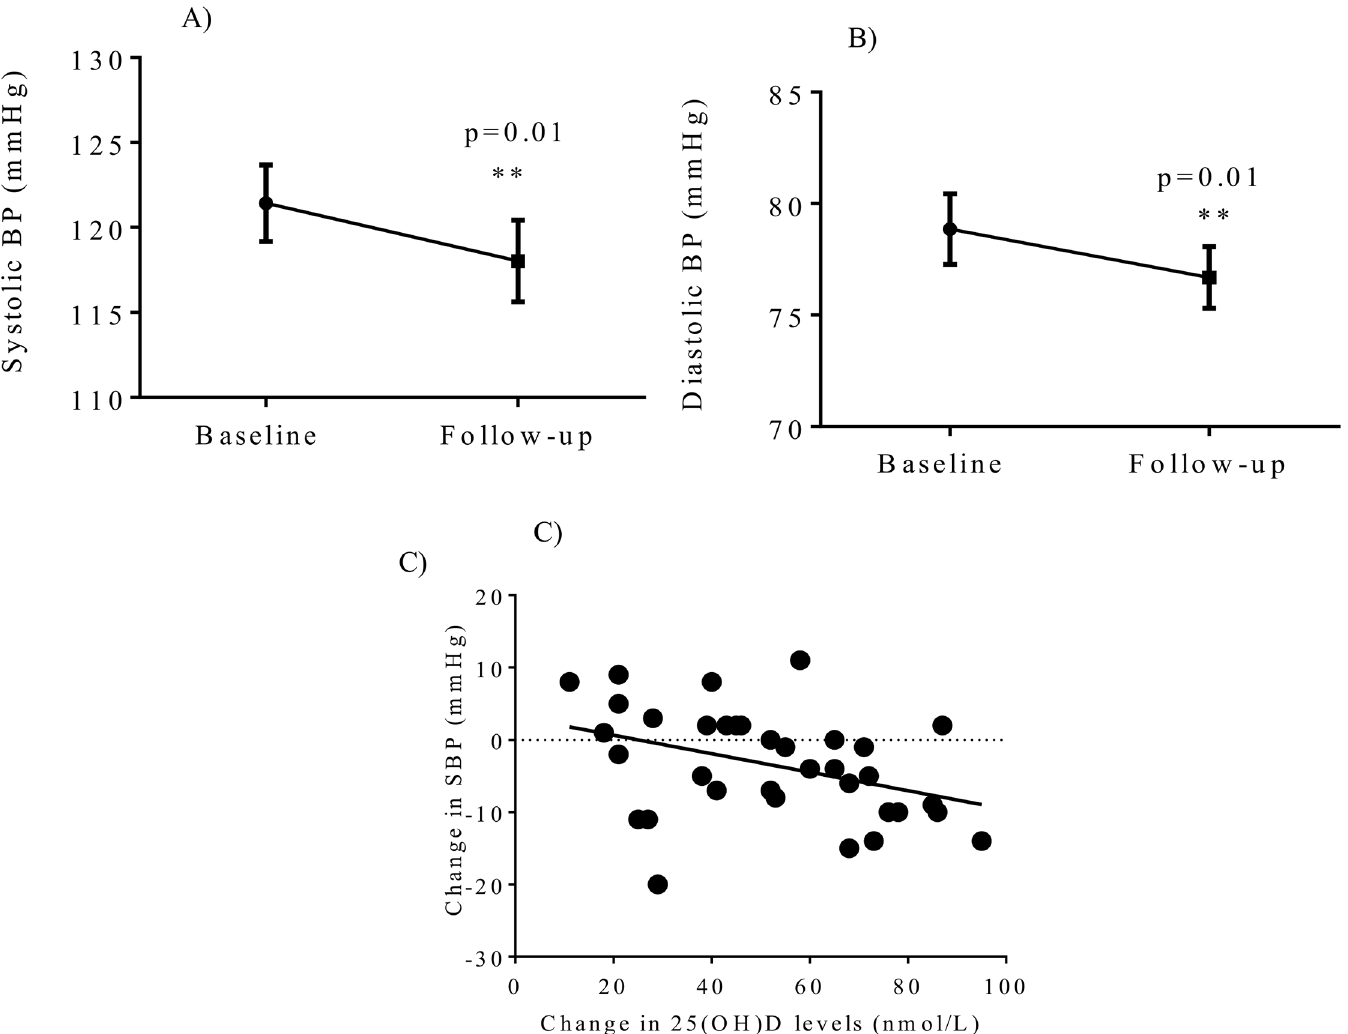
Fig 3. Vitamin D supplementation after 12 weeks significantly reduced(A) systolic blood pressure, and (B) diastolicblood pressure. There was a significant correlation betweenan increase in 25-hydroxyvitamin D levels and loweringof systolic blood pressure (C).